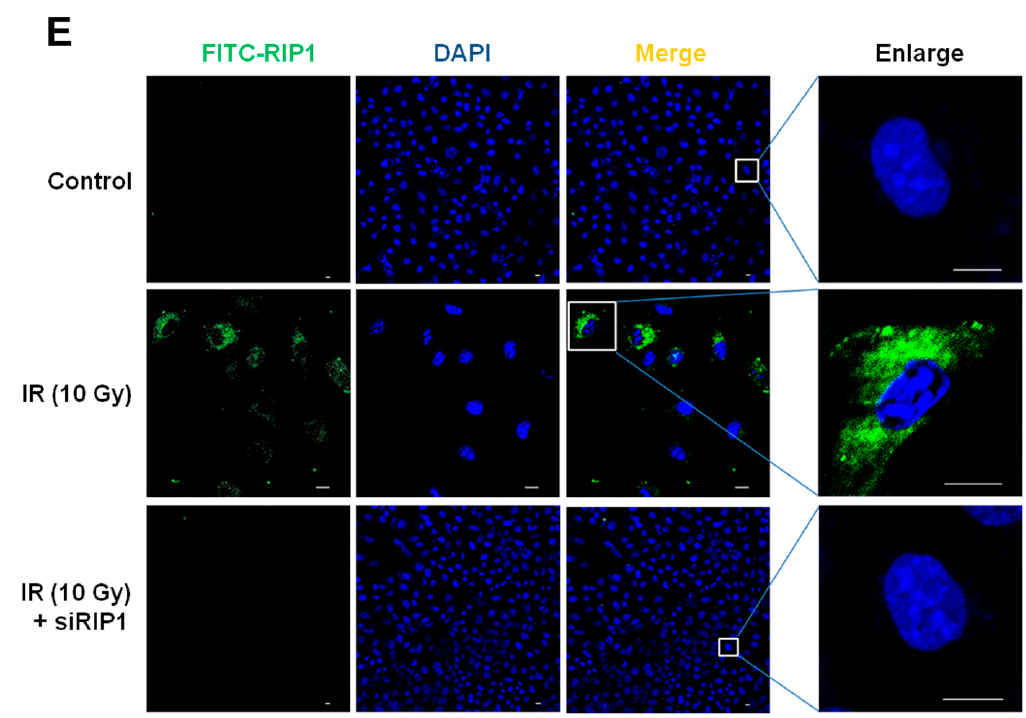
Figure 5. IR induces invasion/migration by promoting EMT via RIP1 activation. ( A , B ) A549 cells transfected with control or RIP1 siRNA for 24 h were subjected to invasion and migration assays. (***; p < 0.001) ( C , D ) Lysates from A549 cells transfected with control or RIP1 siRNA for 24 h were subjected to Western blot analysis for RIP1, MMP-2, MMP-9 EGFR, p-EGFR, Src, p-Src, STAT3 p-STAT3, vimentin and β -actin (loading control). ( E ) Immunofluorescence staining of RIP1-positive A549 cells after IR exposure. Endogenous RIP1 expression in IR treated or non-treated A549 cells was determined via immunofluorescence staining. A549 cells were stained with DAPI to visualize nuclei (blue) and immunolabeled with an anti-RIP1 antibody, which was detected with FITC-conjugated IgG (green). Scale bar: 10 μ m.